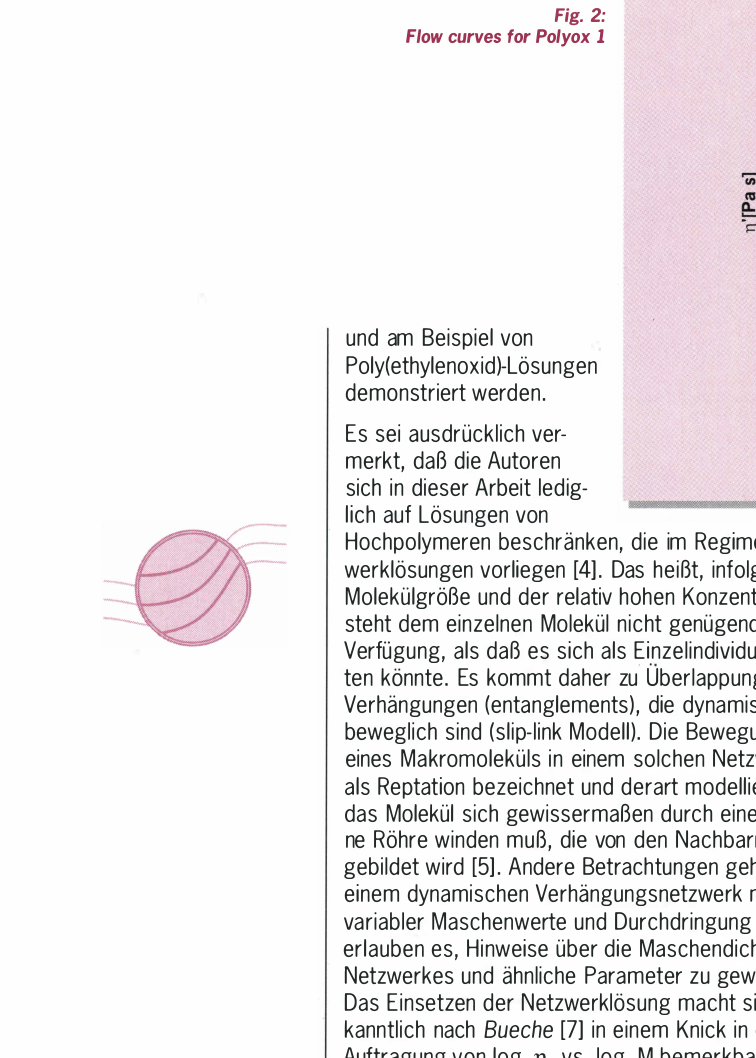
Flow curves for Polyox 1